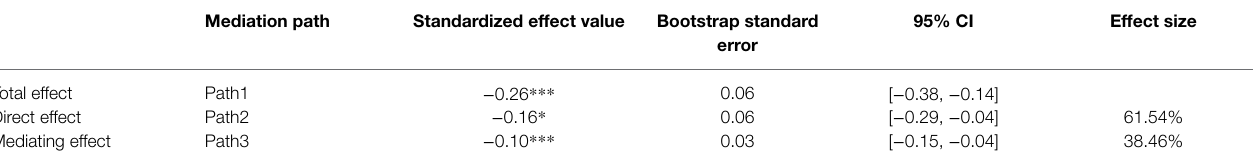
TABLE 4 | Total effect, direct effect and mediating effect.